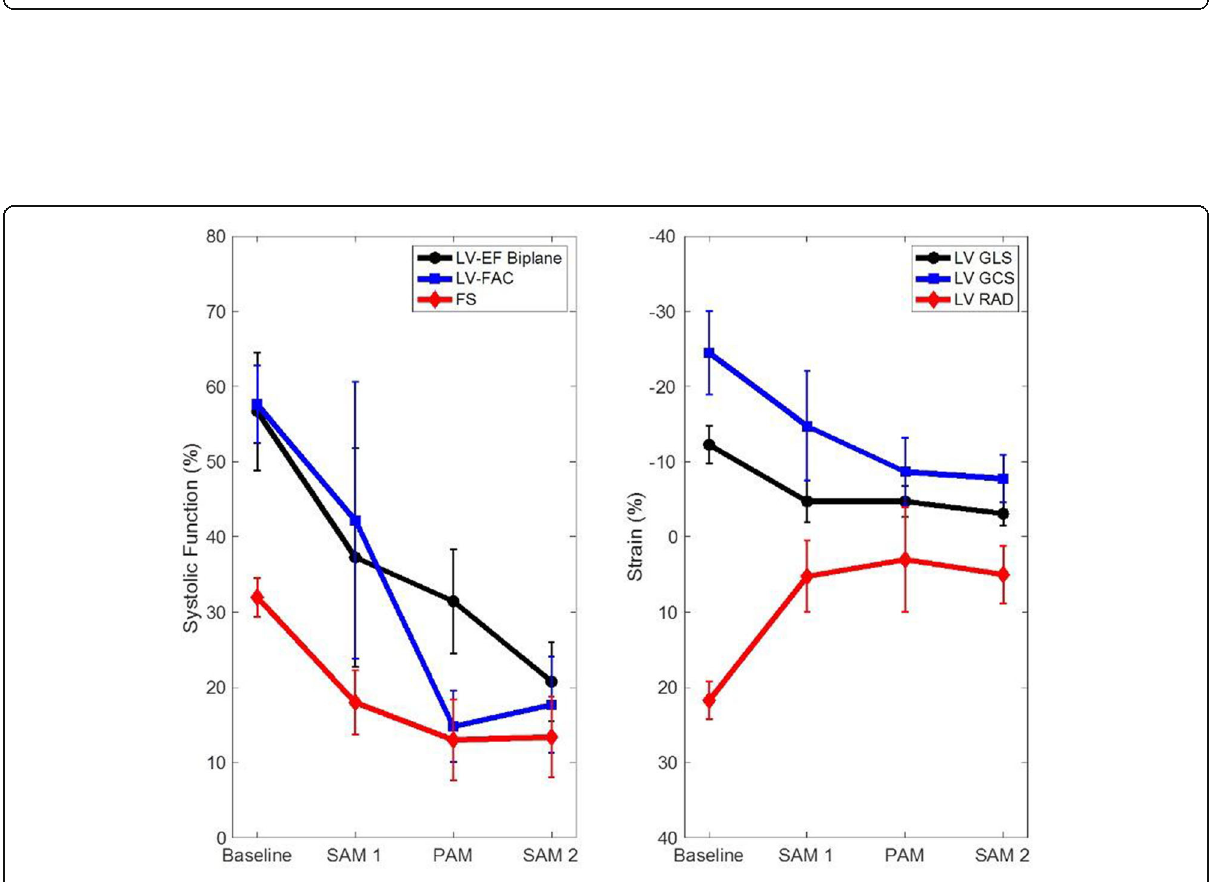
Fig. 2 Representative echocardiographic images obtain with our 3D-printed set-up in working mode during ESHP. ESHP, ex situ heart perfusion; LV, left ventricular